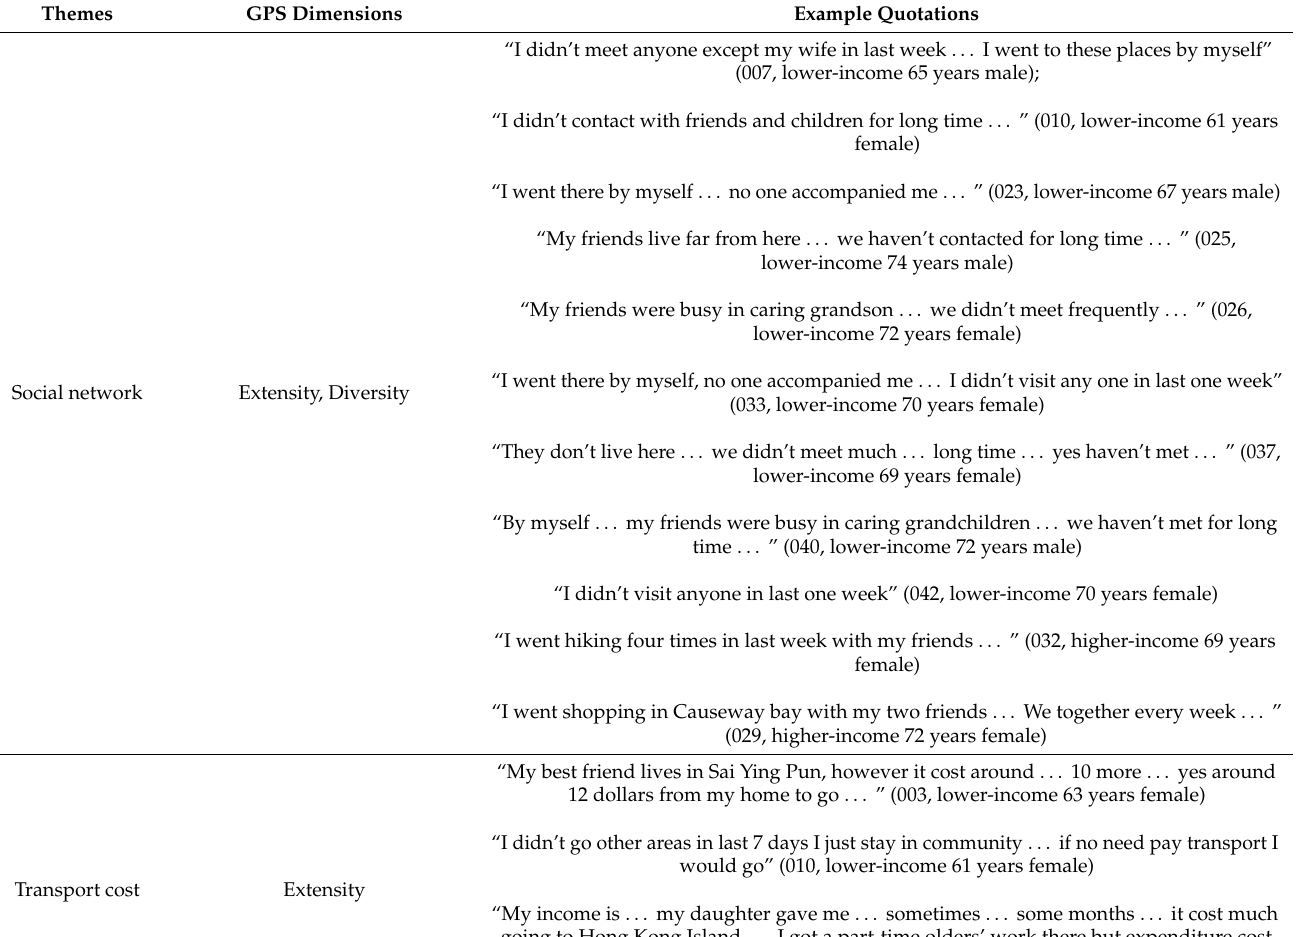
Table 5. Dominant themes related to GPS dimensions and example quotations from